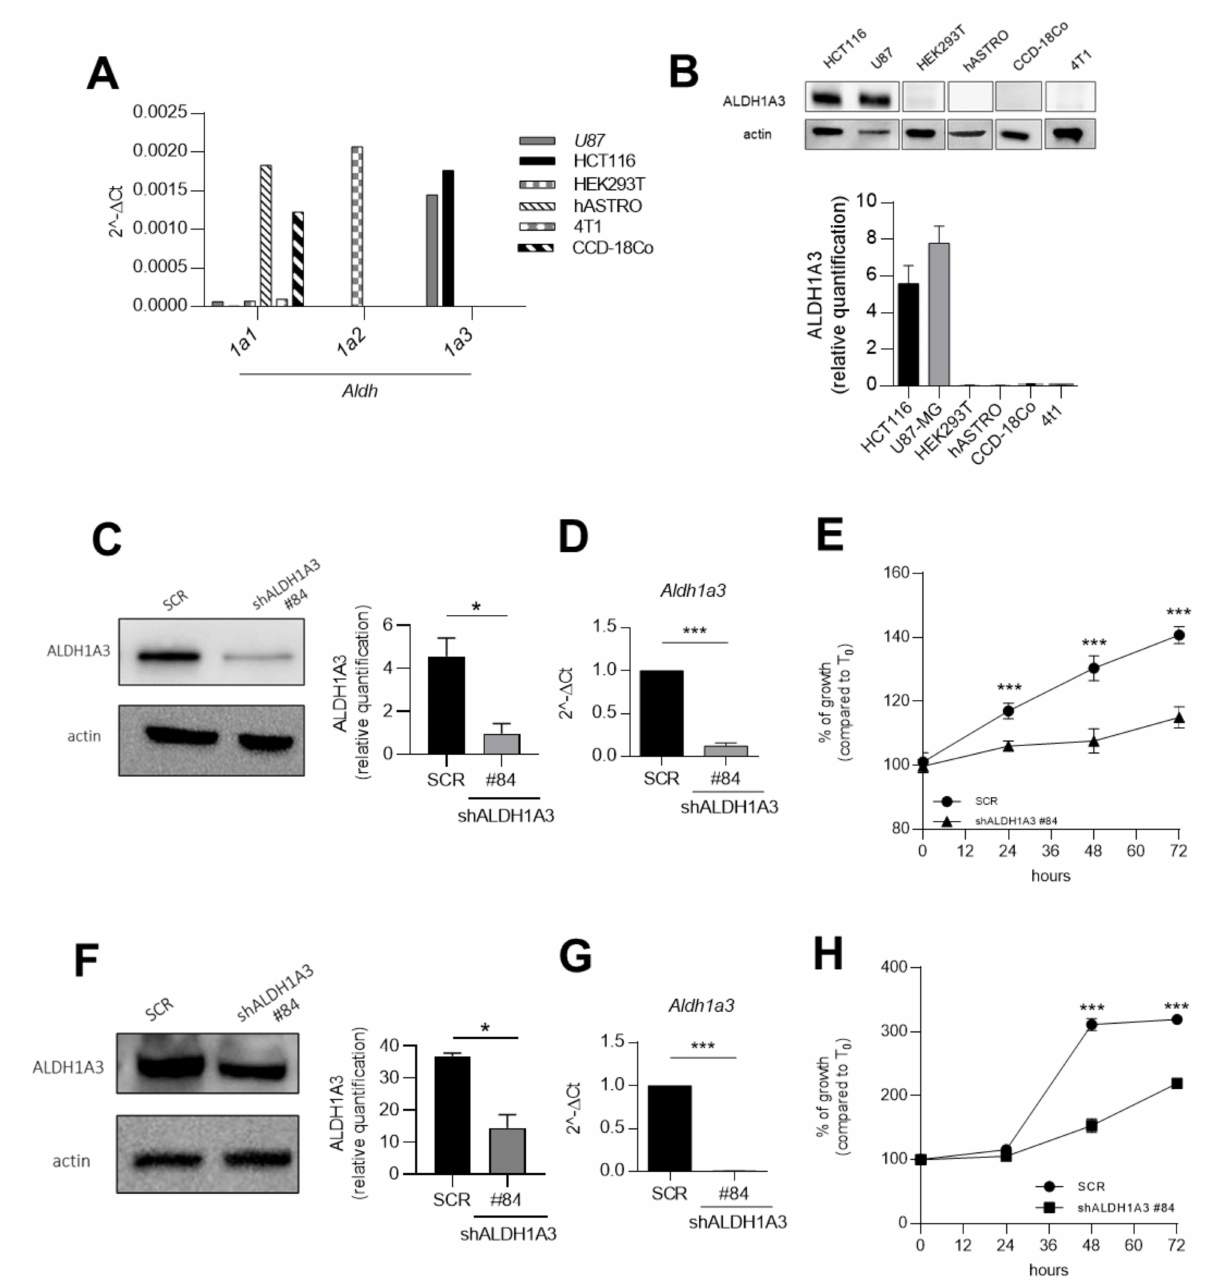
Figure 1. ALDH1A3 is overexpressed in glioblastoma U87MG and colorectal cancer HCT116 cell lines and its silencing determines a decrease in cell growth. ( A ) Gene expression analysis quantified by qPCR in U87MG, HCT116 cell lines and their negative controls (HEK293T, hASTRO, CCD-18Co and 4T1) of ALDH1 isoforms, n = 2 independent experiments. ( B ) Representative western blot (up) and quantification (down) of ALDH1A3 in U87MG, HCT116 cell lines and their negative controls. n = 2 independent experiments. ( C ) Representative western blot (right) and quantification (left) of shALDH1A3 knockdown of U87MG cells, n = 2 independent experiments. ( D ) qPCR of Aldh1a3 in U87MG cells, n = 2 independent experiments. ( E ) Cellular growth of shALDH1A3 U87MG cells (using shRNA, #84) compared to SCR. 4 replicates of n = 4 independent experiments. ( F ) Representative western blot (right) and quantification (left) of shALDH1A3 knockdown of HCT116 cells. n = 2 independent experiments. ( G ) qPCR of Aldh1a3 in U87MG cells, n = 2 independent experiments. ( H ) Cellular growth of shALDH1A3 HCT116 cells (using shRNA, #84) compared to SCR. 4 replicates of n = 4 independent experiments. (*** p < 0.001, * p < 0.05 by unpaired two-tailed t